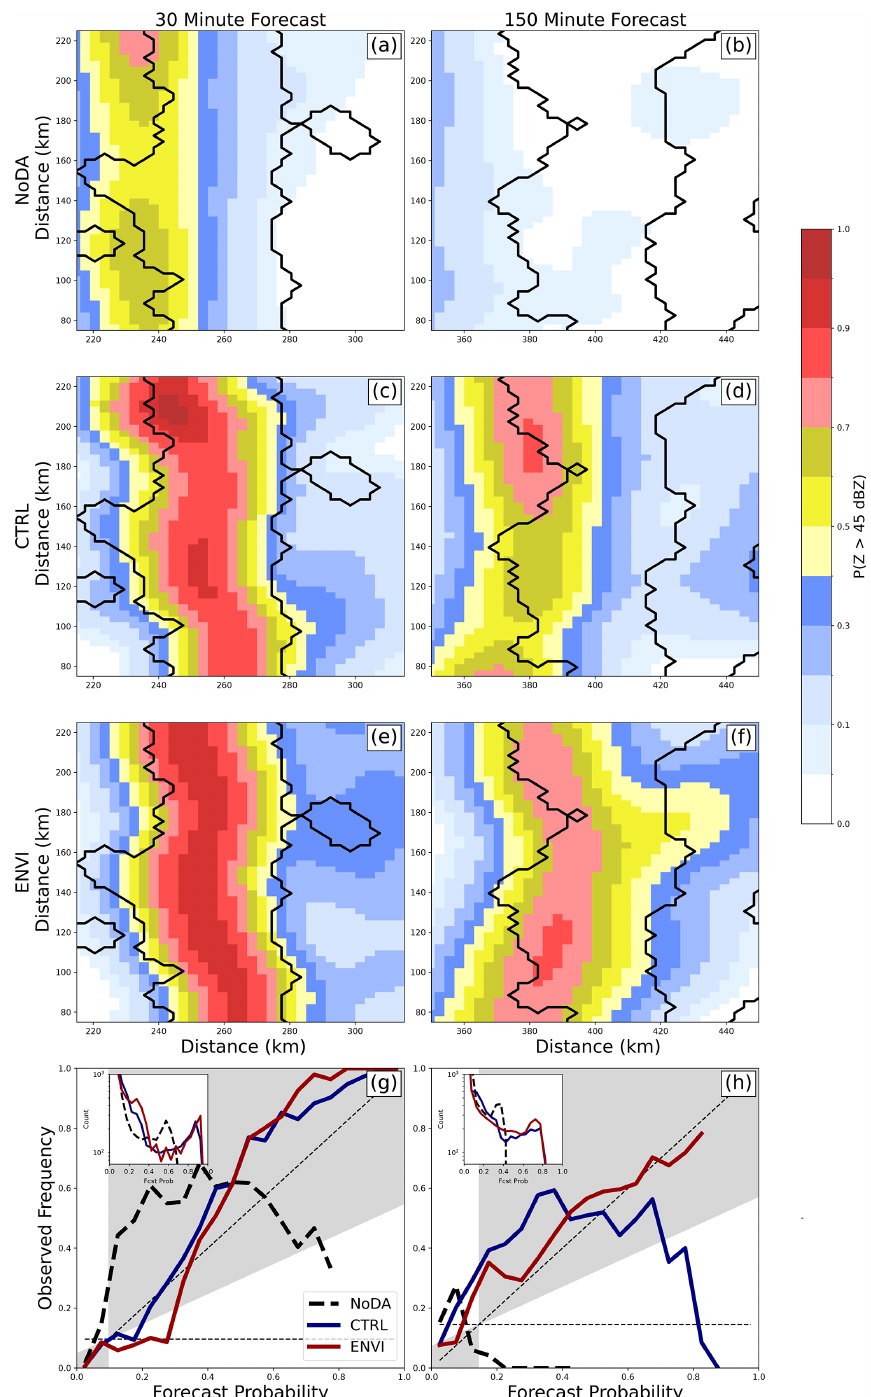
Figure 14. The P(Z > 45dBZ ) at (a, c, e) 30 and (b, d, f) 150min for (a, b) NoDA, (c, d) CTRL, and (e, f) ENVI. Regions where the nature run Z exceeds 45dBZ are contoured black. Attributes diagrams evaluate forecast performance over the full experiment domain at (g) 30 and (h)